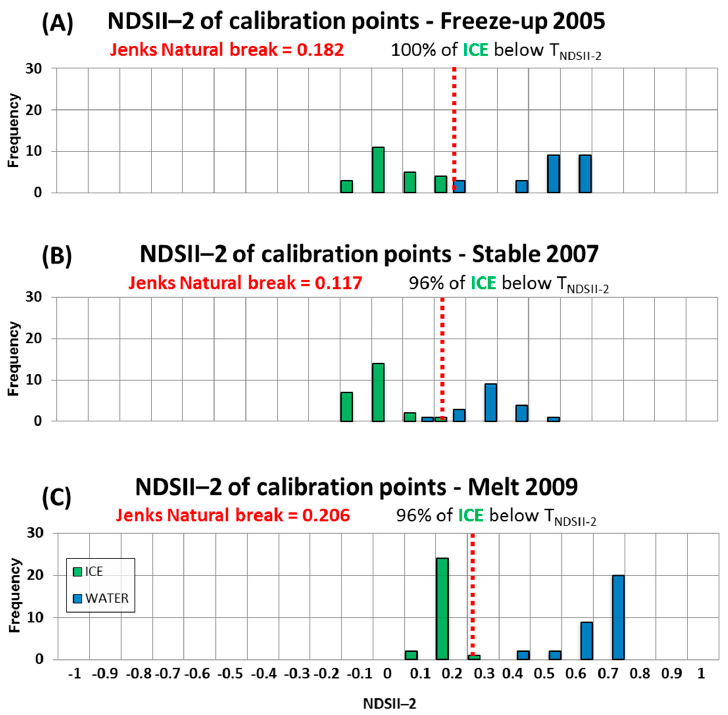
Figure 7. ( A – C ) Distribution of photo-interpreted calibration data points compared to the obtained T NDSII-2 threshold values obtained using Jenks Natural break method for all periods of the ice